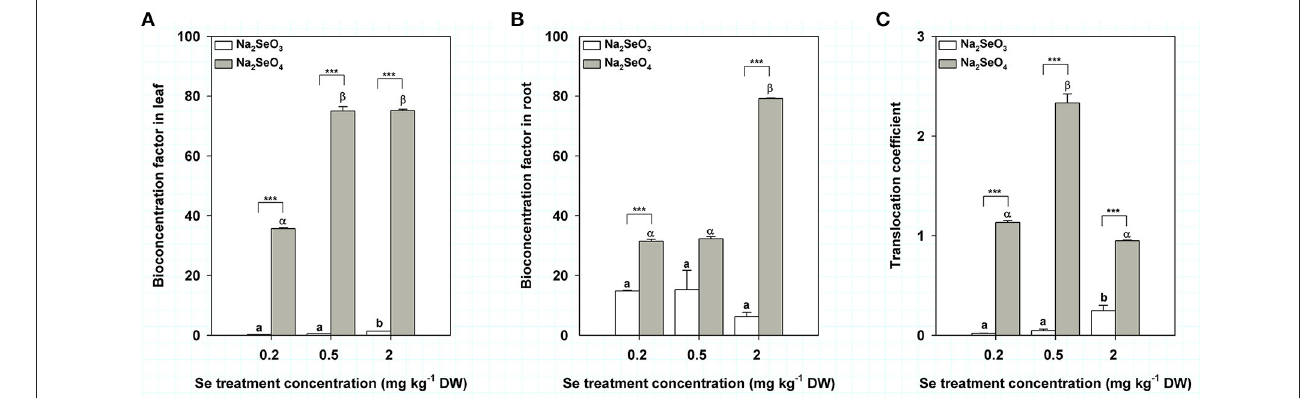
FIGURE 3 | Se bioconcentration factors and translocation coefficients in turnip plants treated with different concentrations of Se (IV) or Se (VI) by soil addition. (A) Se bioconcentration factors in turnip leaves. (B) Se bioconcentration factors in turnip root. (C) Se translocation coefficients in turnip plants. Data represent means ± SE ( n = 3). Bars labeled with different letters (a, b or α , β ) are significantly different among different Se concentrations of Se (IV) or Se (VI) ( P < 0.05) (A–C) . ***Represents a significant difference between two treatments ( P < 0.001) (A–C) .